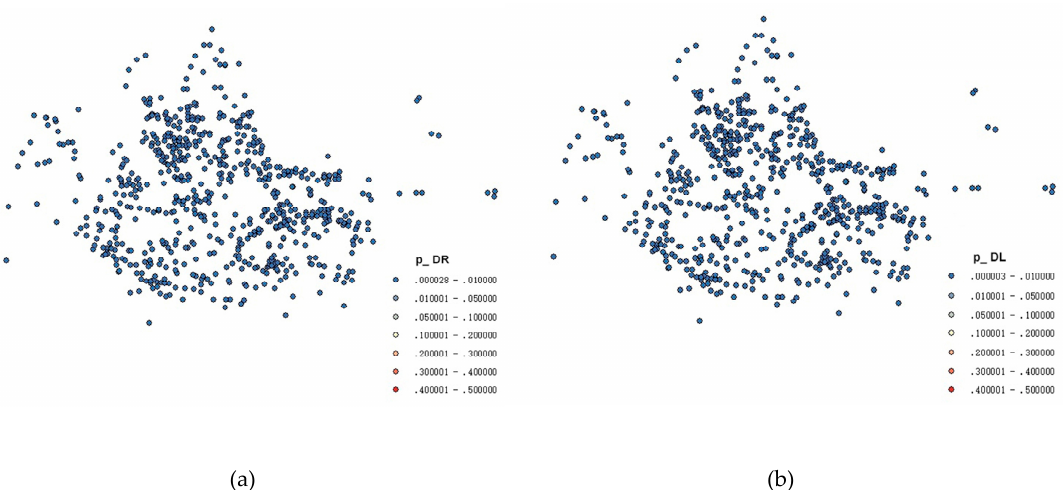
Figure 5. P-value distribution of distance to river ( a ) and lake ( b ).